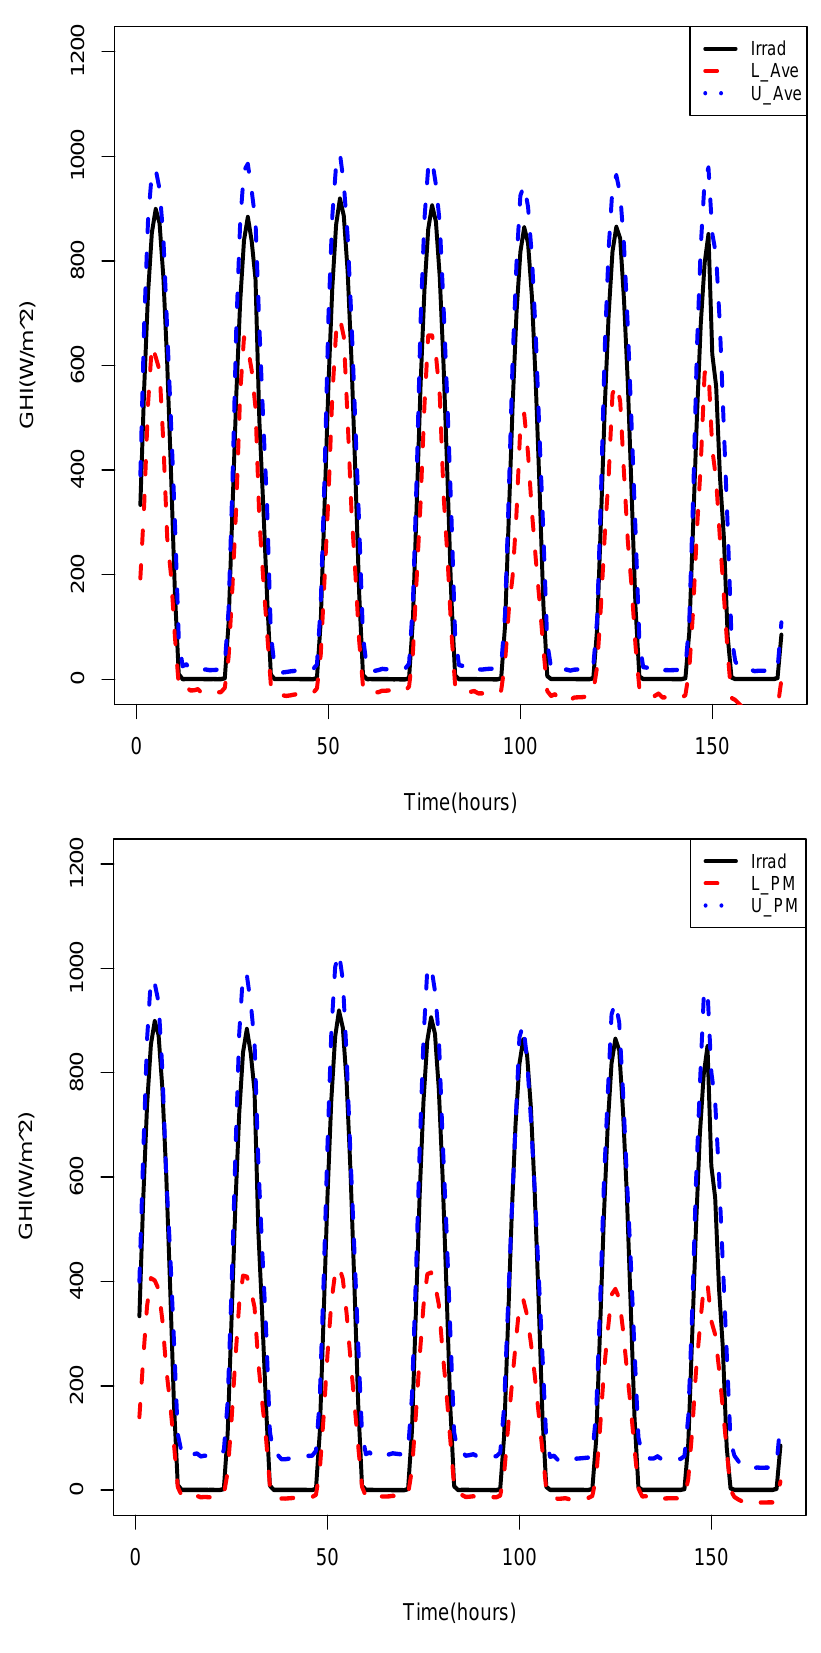
Figure 10. Top panel: Actual GHI with lower and upper 95% prediction intervals (Averaged prediction intervals). Bottom panel : Actual GHI with lower and upper 95% prediction intervals (PM prediction